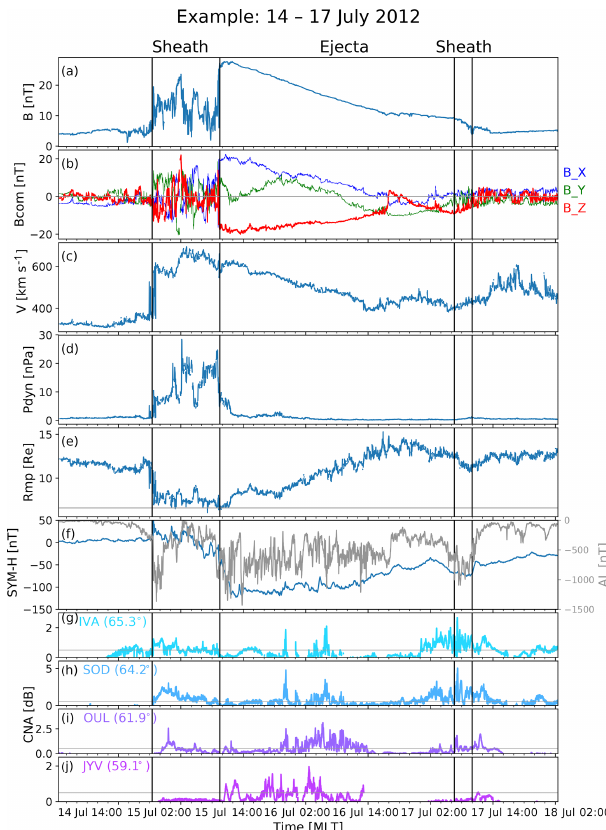
Figure 3. The ICME event of 14–17 July 2012. The top seven pan- els give (a) the IMF magnitude, (b) IMF components in GSM co- ordinates (blue: B X , green: B Y , and red: B z ), (c) solar-wind speed, (d) solar-wind dynamic pressure, (e) subsolar magnetopause posi- tion from Shue et al. (1998), and (f) SYM-H (blue) and AL (grey). The bottom four panels (g–j) give riometer CNA data for IVA, SOD, OUL, and JYV. Time is given in MLT at the geomagnetic longitude of the riometer stations (here MLT ≈ UT + 2.5h). The vertical lines limit the sheath, flux rope, and “back sheath” (see text for